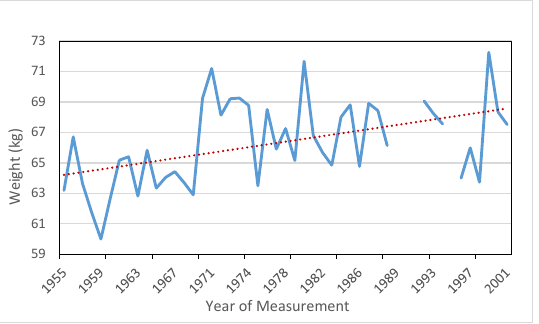
Figure 6. Annual average weights (1955 – 2001) in SB. Trend line. Source: AMSB, ACDS. Own work.